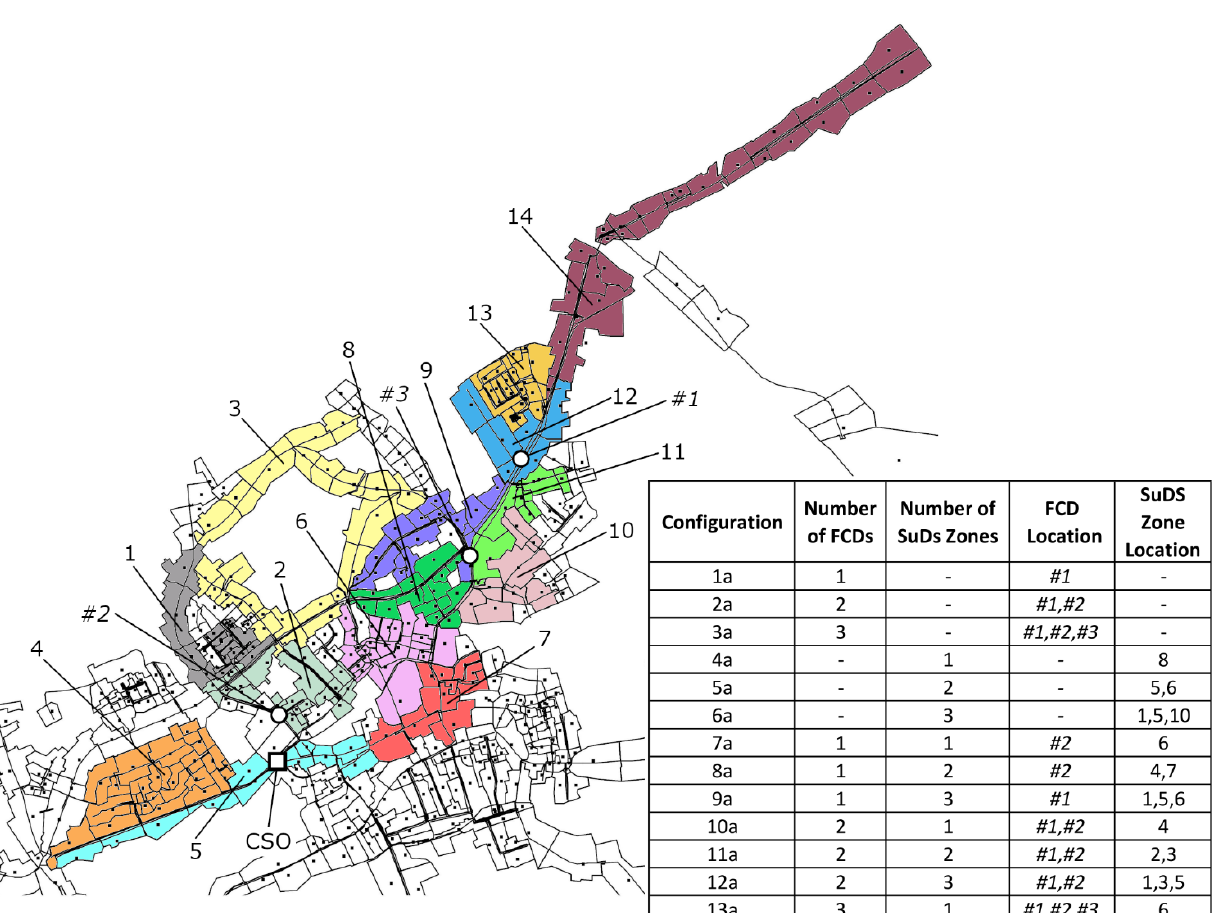
Figure 4. Optimal FCD and/or SuDS locations selected by the GA in the Arendonk catchment.